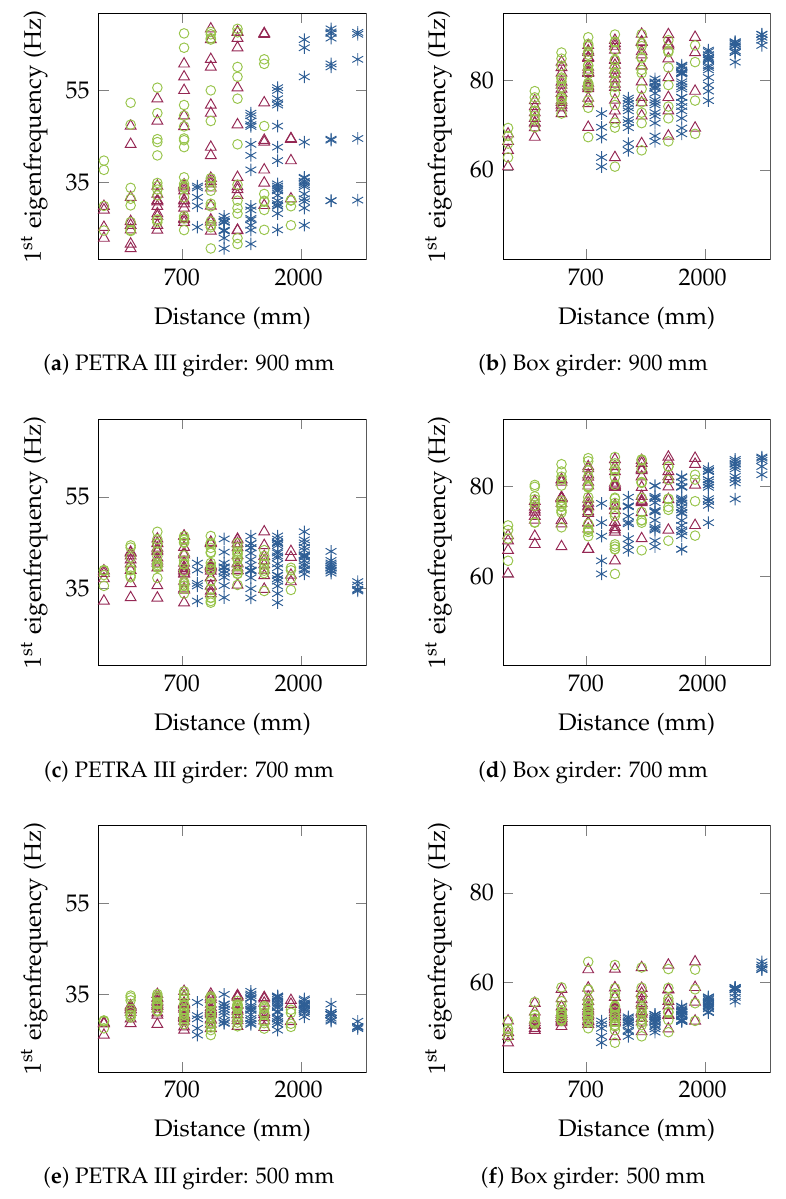
Figure 21. First eigenfrequency of the magnet–girder assembly depending on the position height and the distance between the three support points located at the front eft (SP 1), the front right (SP 2), and the back (SP 3) of the girder. The support points are positioned at different heights (i.e., z values) of 900 mm ( a ), 700 mm ( c ), and 500 mm ( e ) for the PETRA III girder and of 900 mm ( b ), 700 mm ( d ), and 500 mm ( f ) for the box girder. The distances in x direction between SP 1 and SP 2, between SP 1 and SP 3, and between SP 2 and SP 3 are symbolised by blue asteriks, red triangles, and green circles,